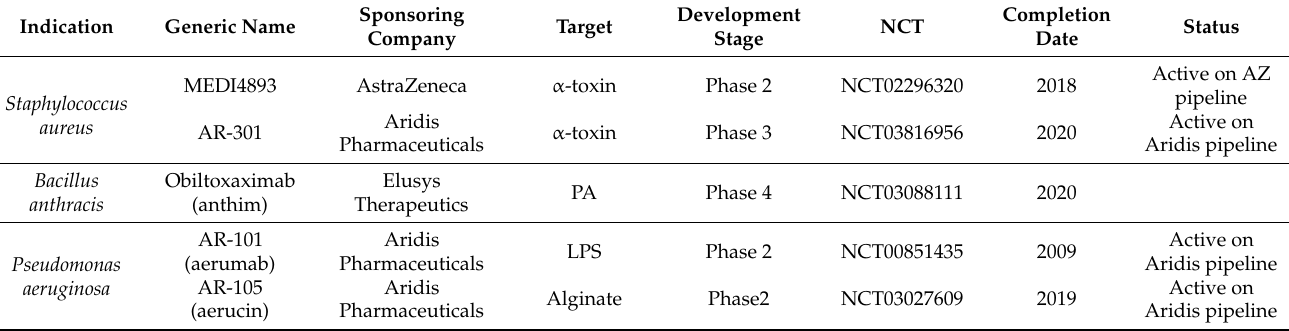
Table 4. Therapeutic antibodies for bacterial respiratory